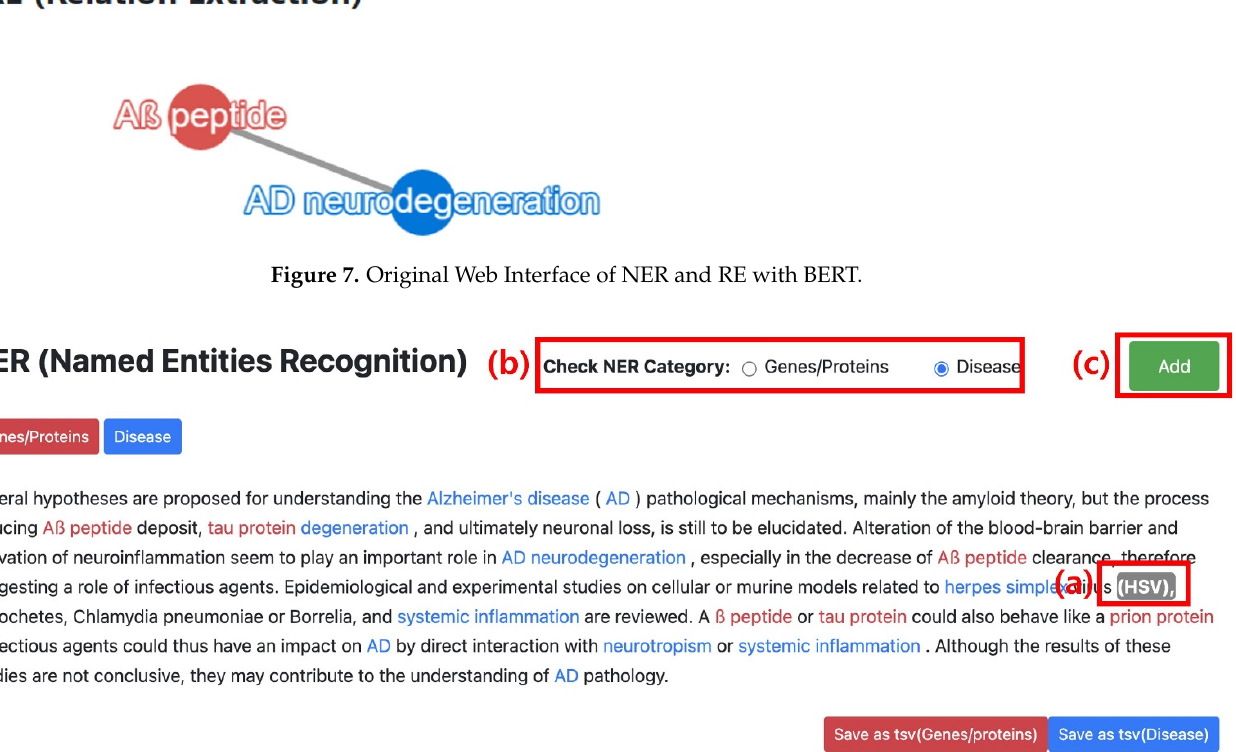
Figure 8. Proposed Web Interface of NER and RE with BERT using tagging tool system. ( a ) It is a word chosen by the user to form NE. ( b ) It is a user interface for categorizing the selected term. ( c ) It is a category-adding button.